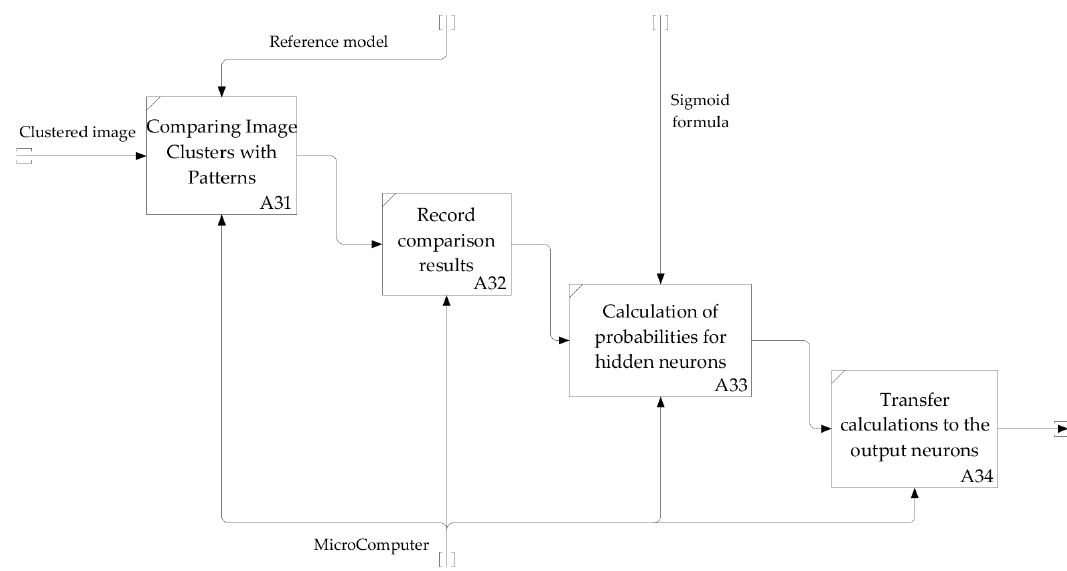
Figure 6. The diagram of second-level decomposition of the functional block A3 in diagnostics of the FC gripping accuracy.